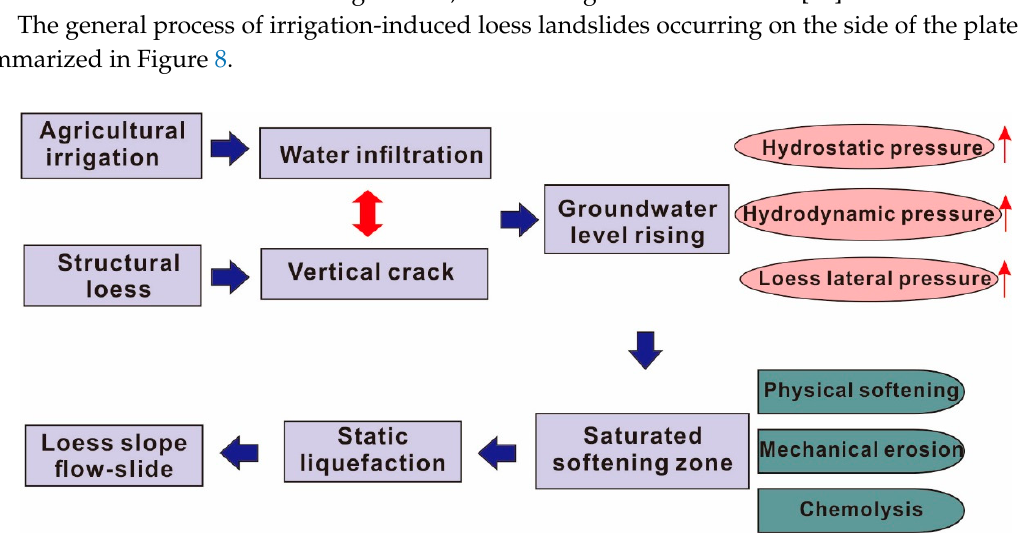
Figure 8. Occurrence of loess landslides due to irrigation on the side of the plateau.